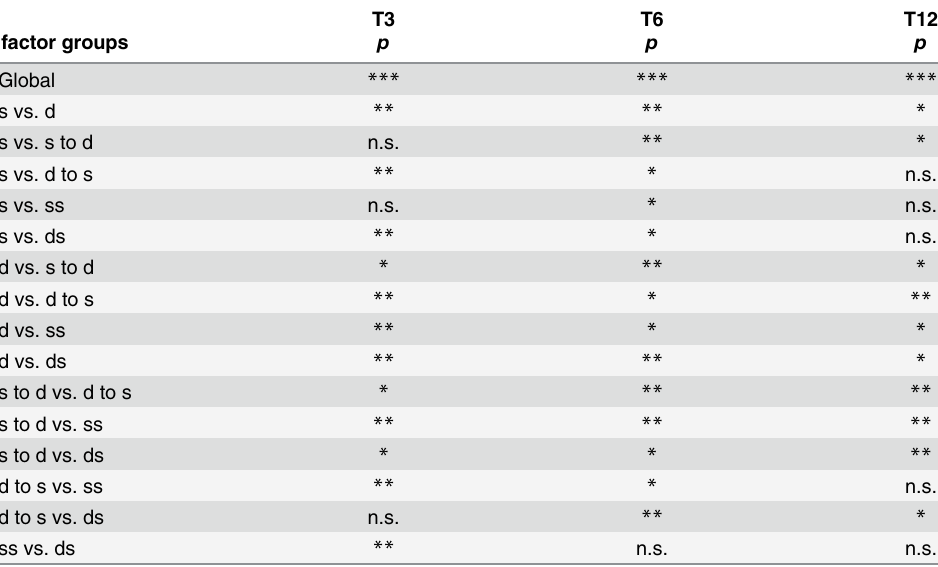
Table 3. PERMANOVA.